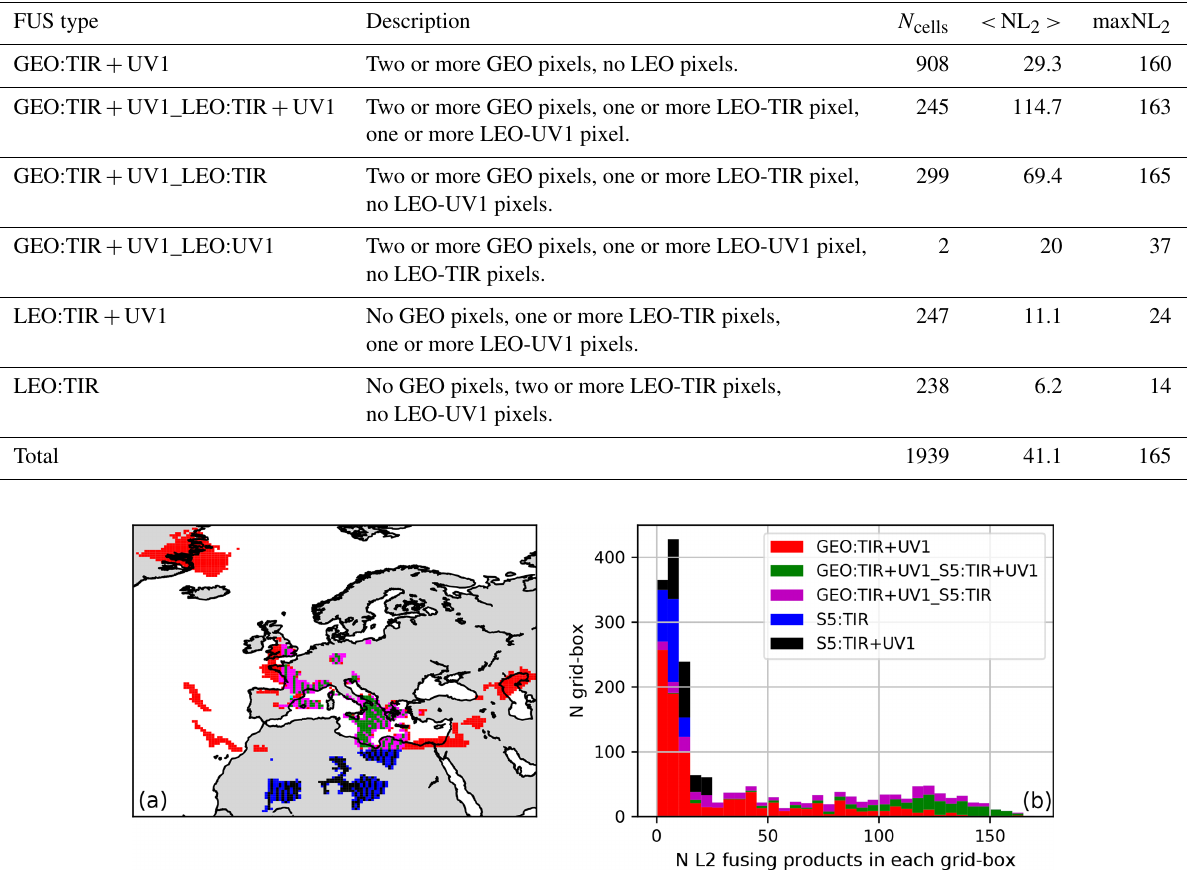
Figure 5. (a) Geographical distribution of FUS products differentiated by FUS type where the effect of the lower resolution of LEO-UV1 with respect to the other L2 products is the cause of the periodic FUS type transitions in the Mediterranean area. (b) Histogram of the number of cells with a given number of L2 measurements differentiated by FUS